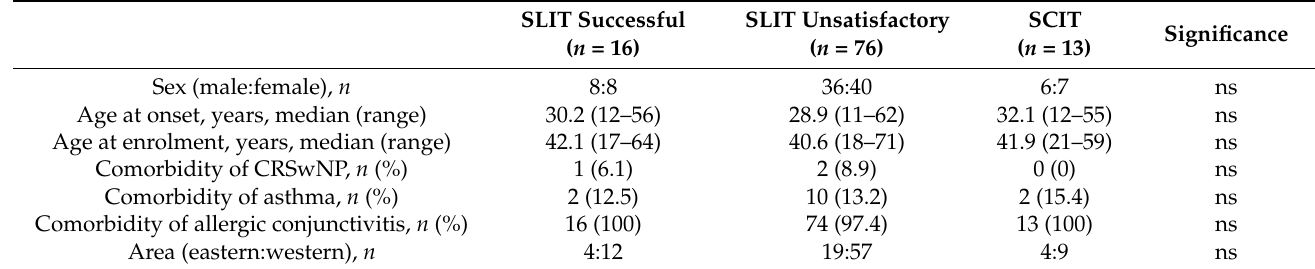
Table 1. Clinical